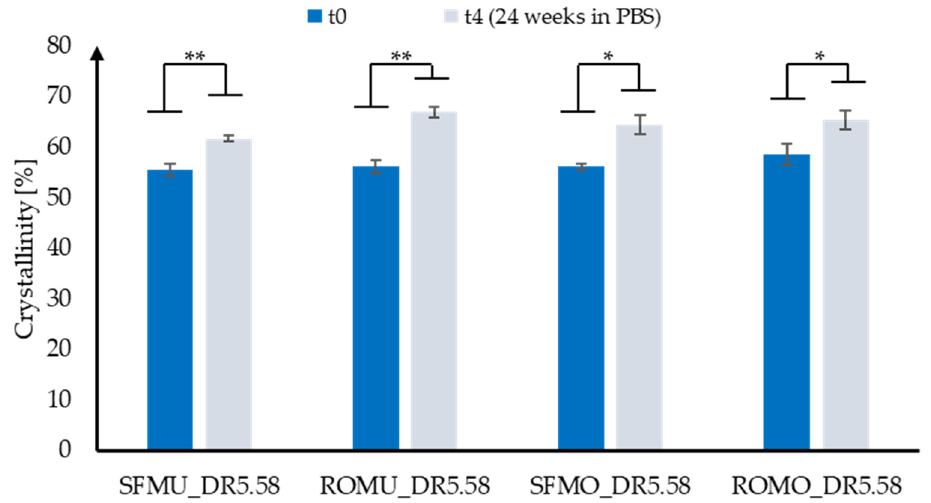
Figure 6. Crystallinity before and after 24 weeks in PBS measured for different fiber morphologies ( n = 3). Significance levels are p < 0.05 (*), p < 0.01 (**).